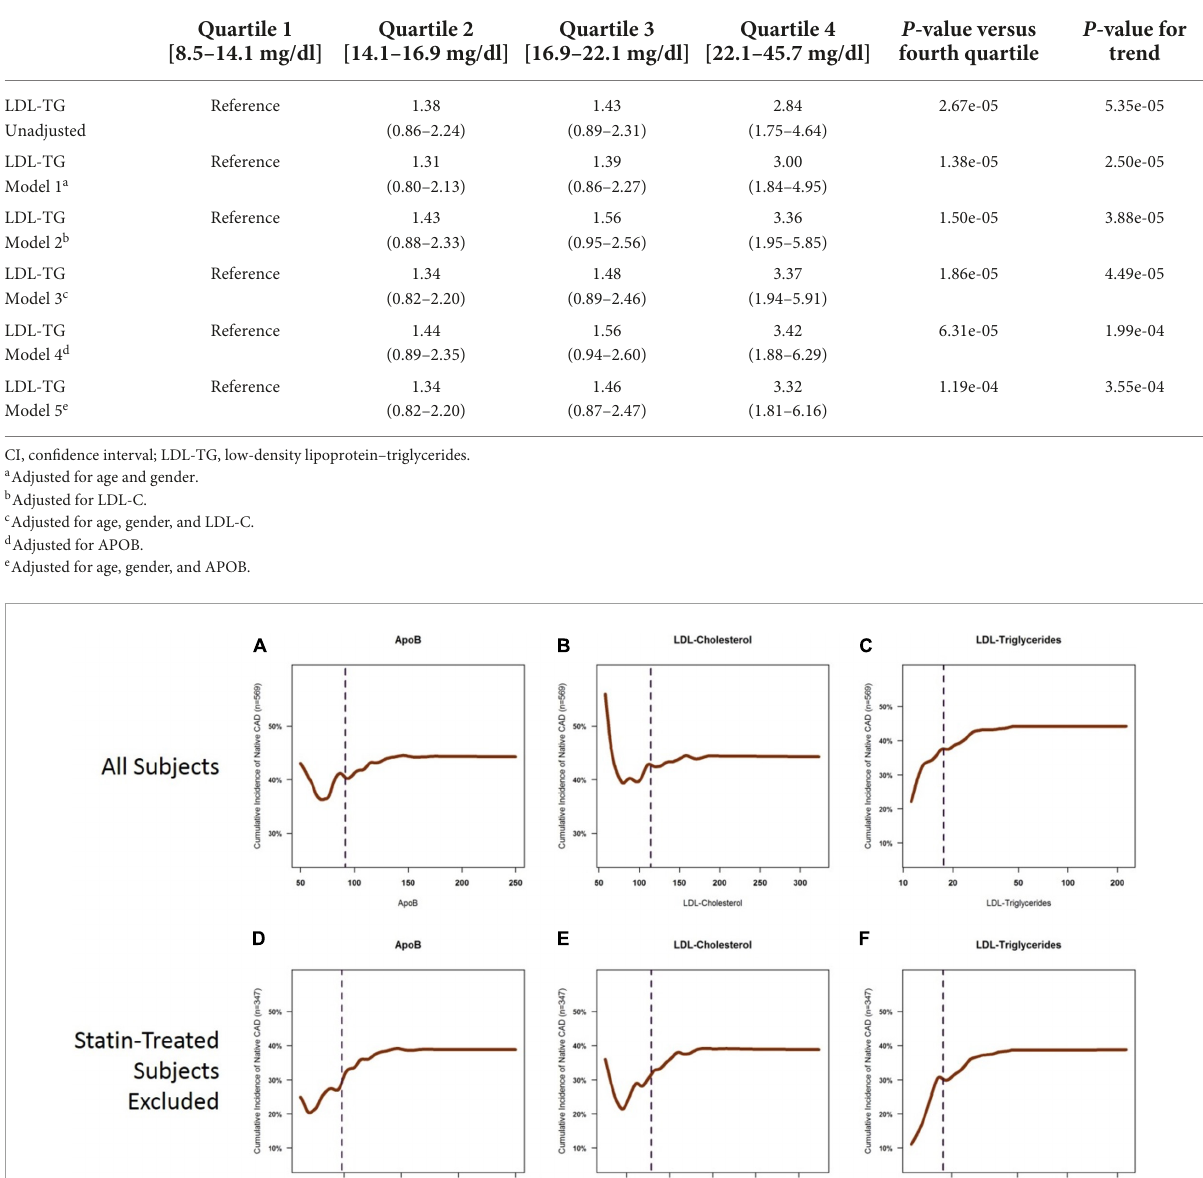
TABLE 1 Odds ratios (95% CI) for atherosclerosis against the lowest quartile of LDL-TG.